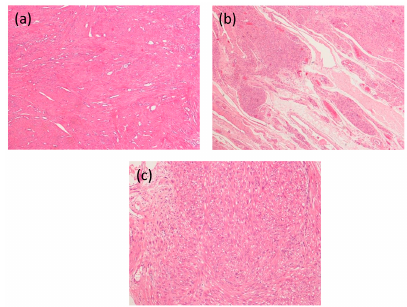
Figure 1. Histological patterns of leiomyoma in the pregnant uterus: ( a ) photomicrograph of non-pregnant normal myometrium; ( b ) photomicrograph of a leiomyoma with extensive mixo-edematous changes in a pregnant woman; and ( c ) photomicrograph of a leiomyoma in a pregnant woman with a cellular area constituted by smooth muscle cells with cytoplasmic vacuoles. Stained with hematoxylin and eosin. Magnification: ( a , b ) 125×; and ( c ) 250×.